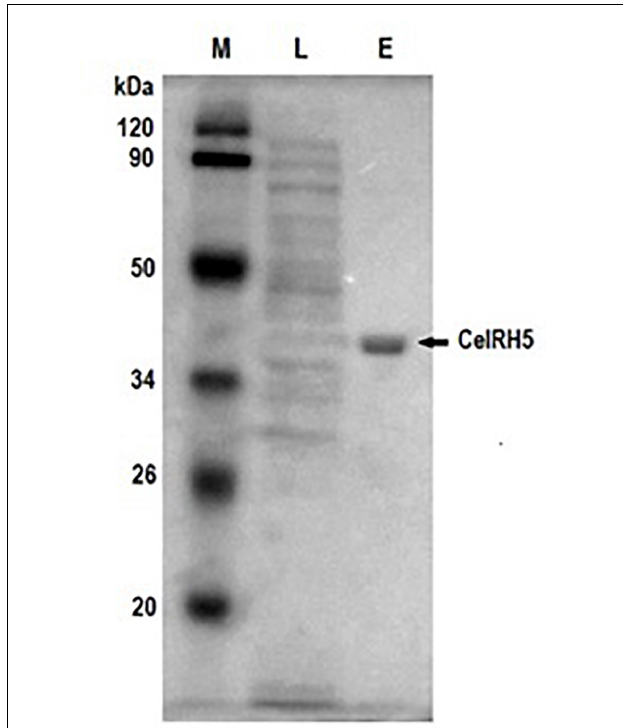
FIGURE 6 | SDS-PAGE of the recombinant cellulase CelRH5 during purification steps. Lane M contains the protein molecular weight markers, lane L is the lysate from the E. coli TOP10/CelRH5 cells after protein overexpression, lane E is the recombinant enzyme CelRH5 eluted following the purification step with the His-tag Ni-NTA